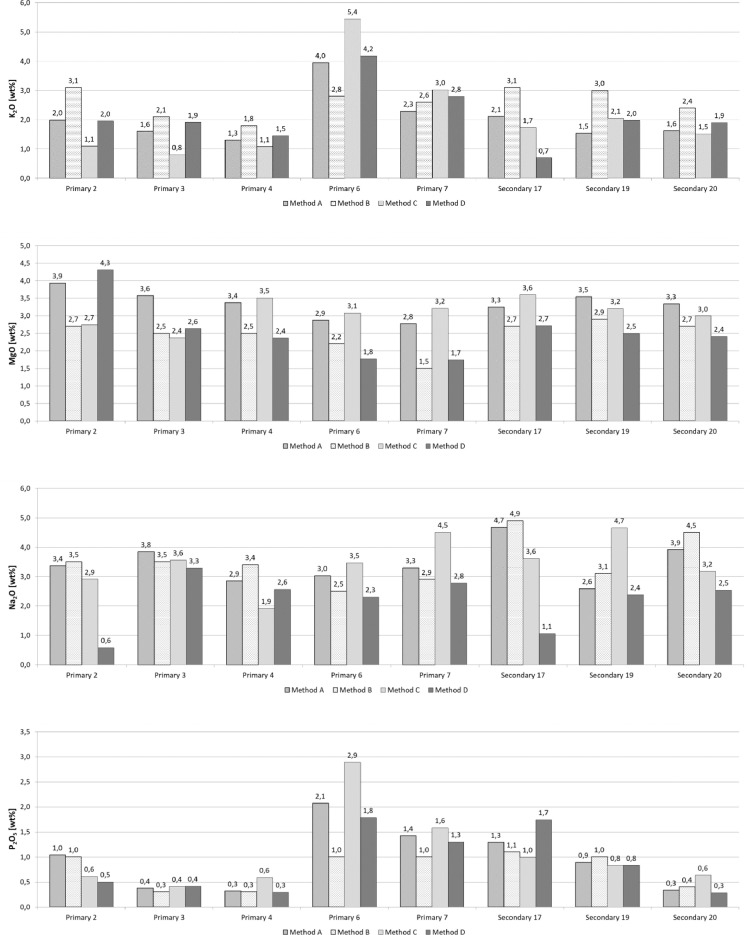
Results for K2O MgO, Na2O and P2O5 and for all analytical methods for randomly selected samples.